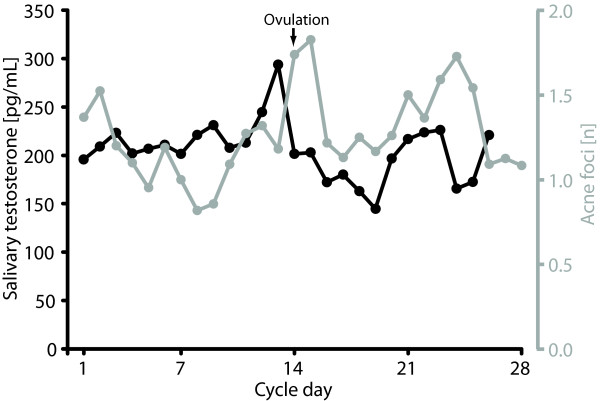
Pilot study results. In a small pilot study, the effect of one female's menstrual cycle on the male partner's mean number of acne foci during 18 months (gray line) and mean salivary testosterone concentrations (black line) during two other months was assessed. A clear peak is seen day 13-15 (around ovulation) with number of acne foci lagging approximately 2 days after the salivary testosterone concentration peak.